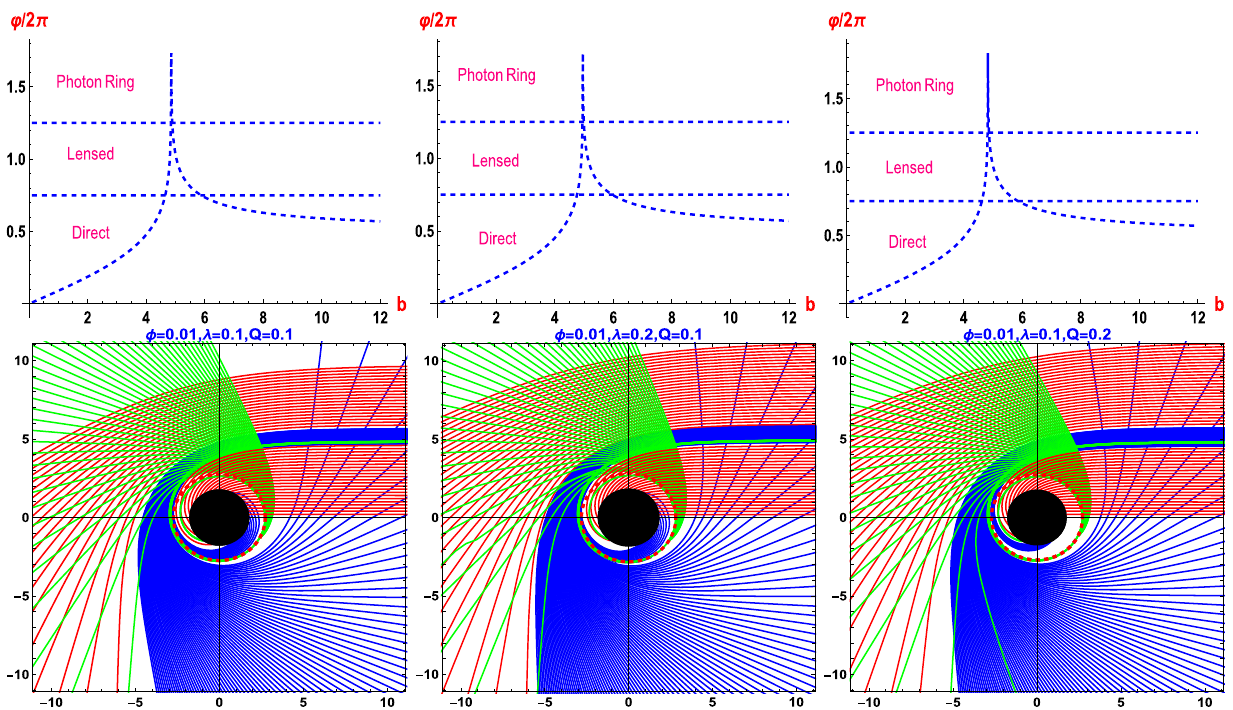
Fig. 4 The light rays for different values of state parameters in Euclidean polar coordinates ( r ,ϕ) with M = 1. Here, the spacings in IP are1 / 5,1 / 100 and1 / 1000 fordirect,lensingandphotonringemissions